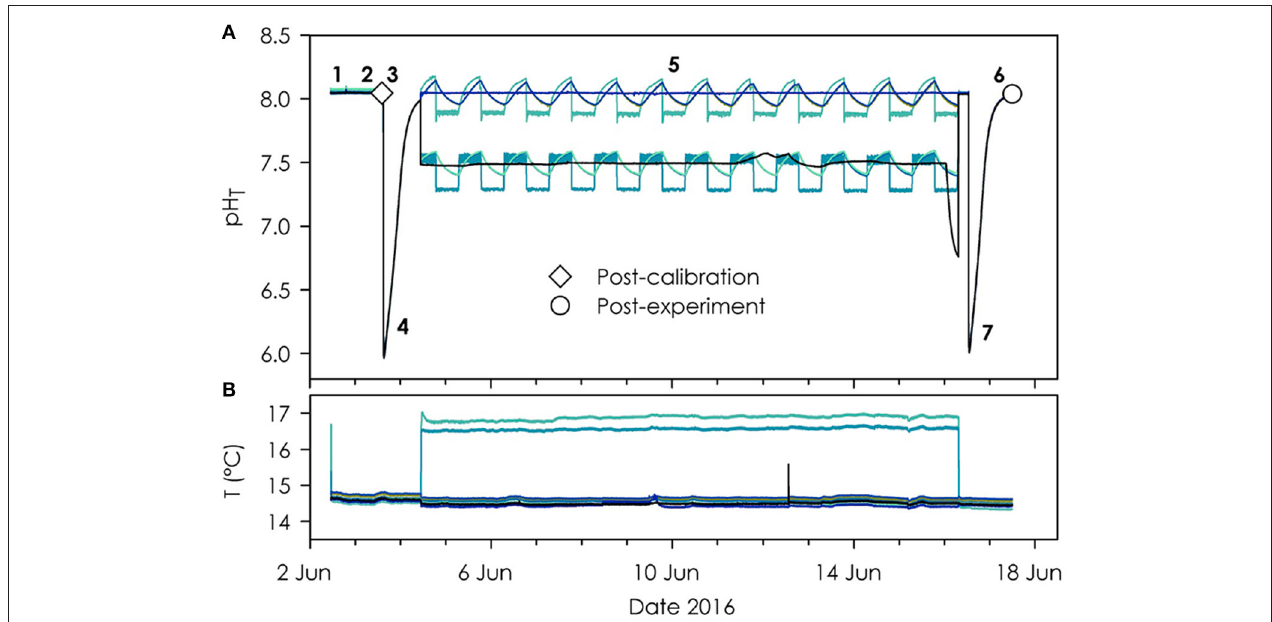
FIGURE 4 | Complete pH T (A) and temperature (B) time-series from eight Durafets during an experiment. Post-calibration (diamond) and post-experiment (circle) reference pH samples and pre- and post-experiment CO 2 spikes are included. Numbered steps follow Table 2 (step 6 and 7 are inverted in this example). Header tanks were warmer than culture vessels, and only two header tanks had Durafets (B) .